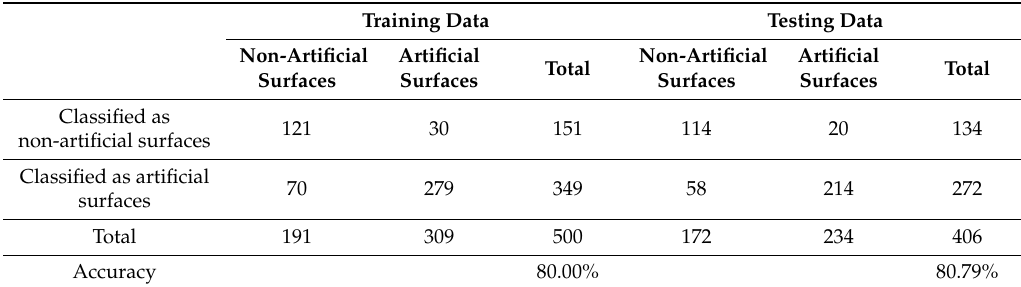
Table 3. Land cover classification model